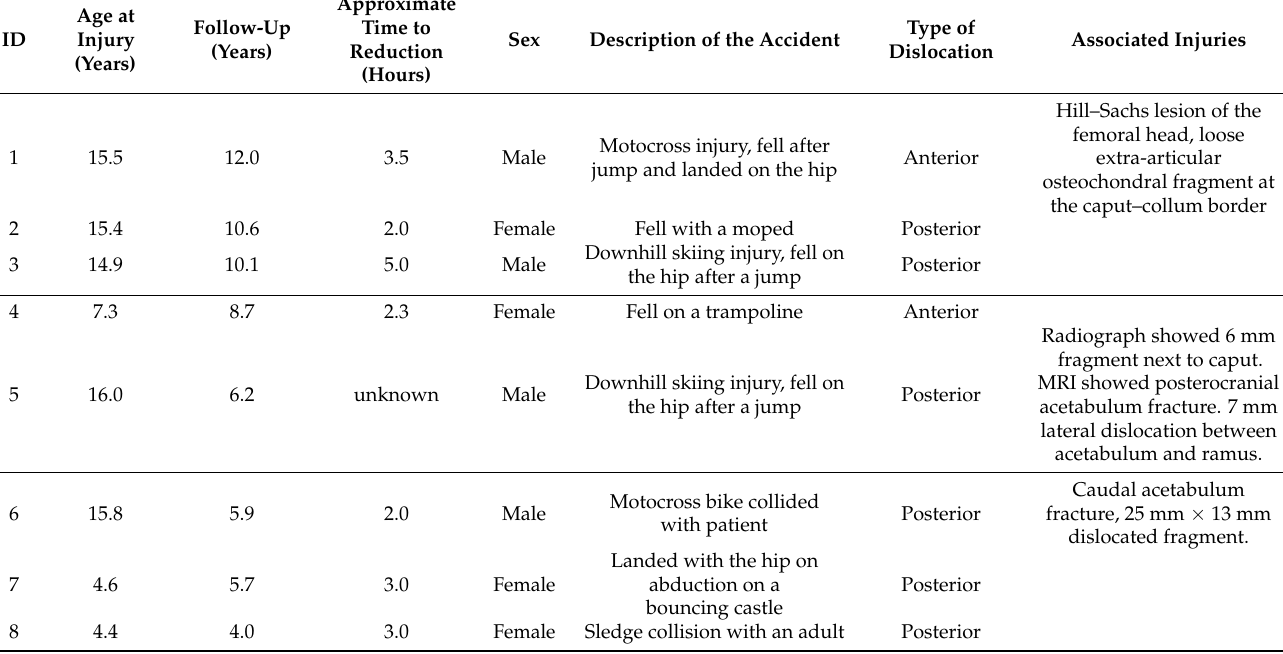
Table 1. Clinical characteristics and etiology of the